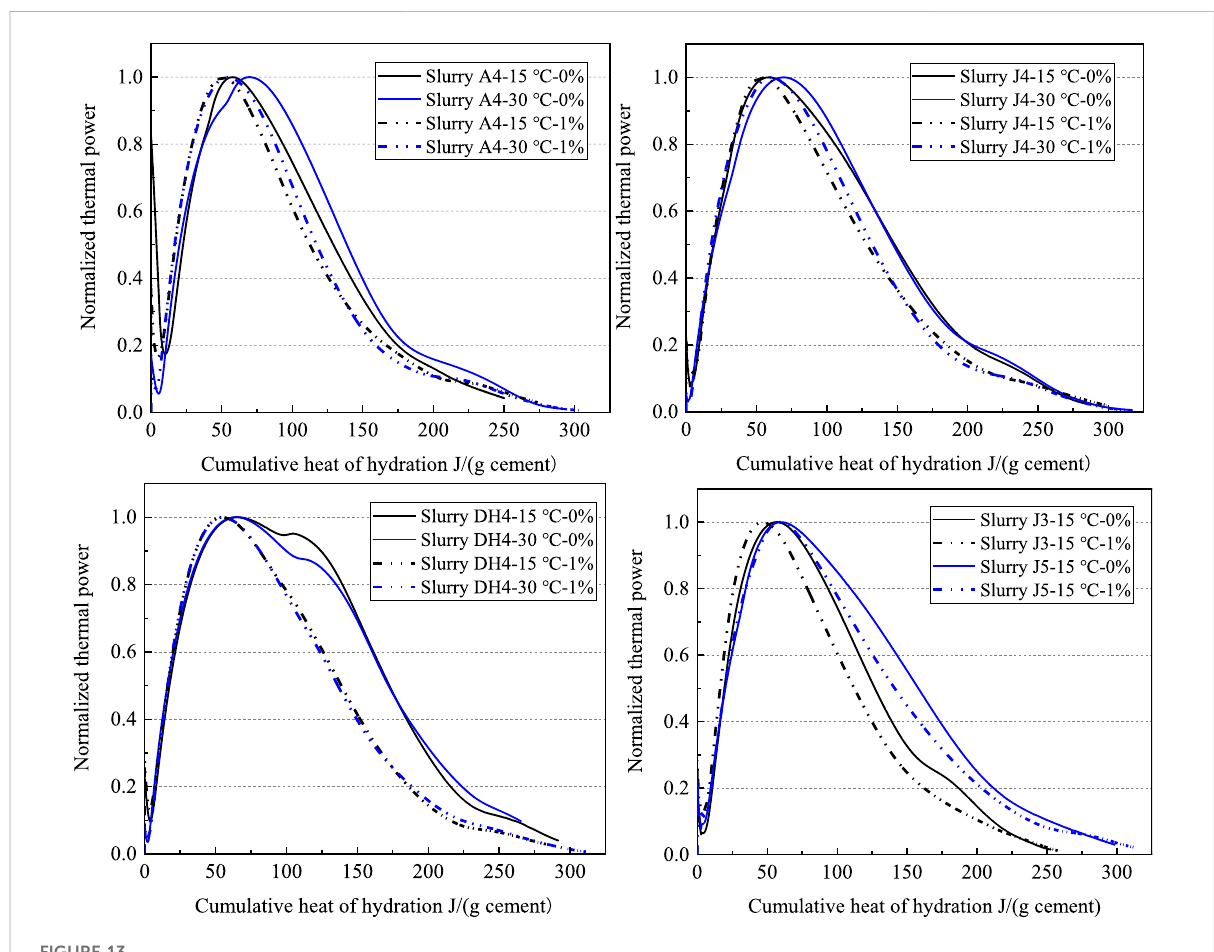
FIGURE 13 In fl uence of the CaCl 2 accelerator concentration on the hydration mechanism pro fi les for different slurries (solid line: 0.0%; dotted line: 1.0%).